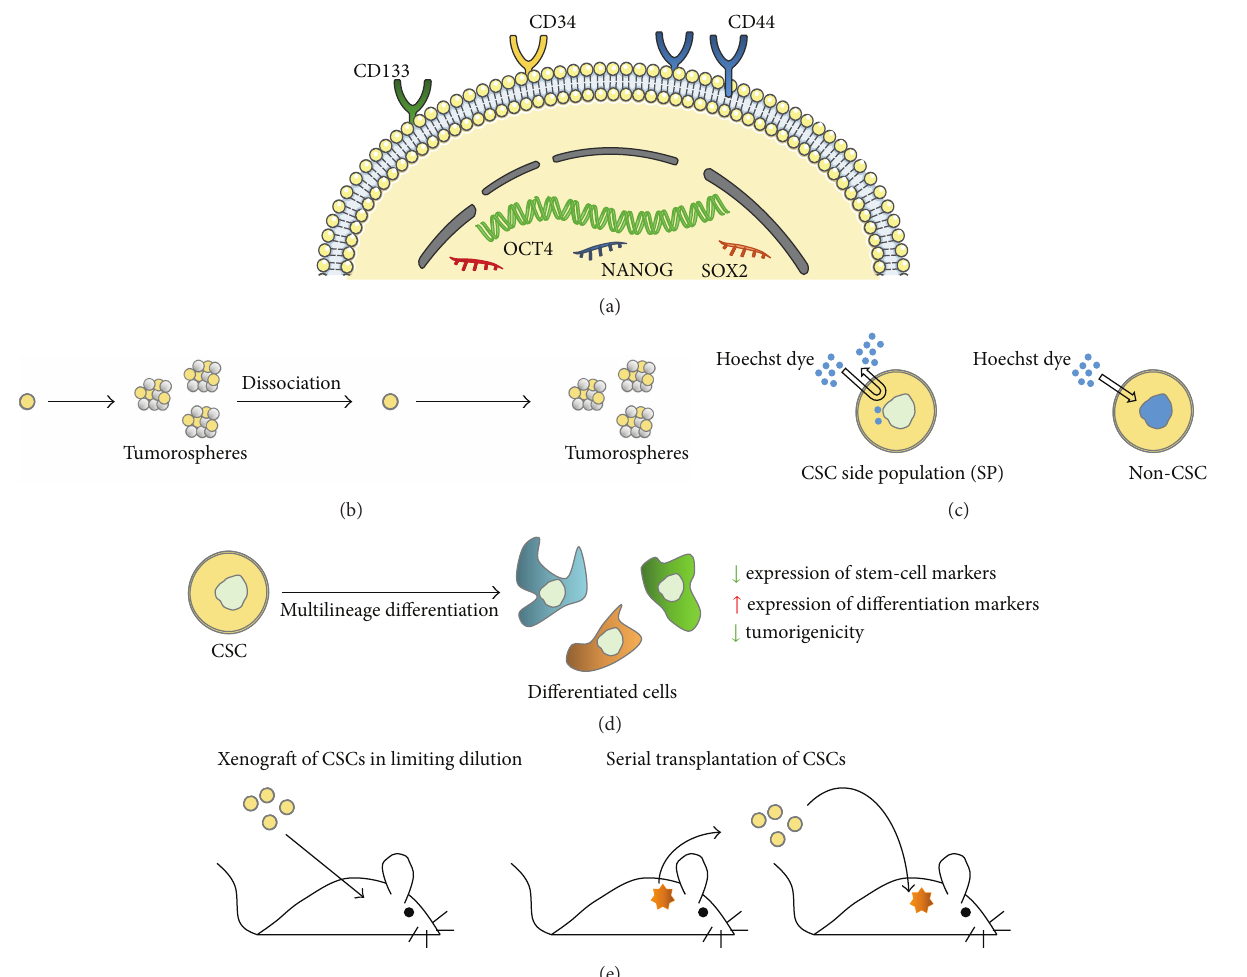
Figure 1: Cancer stem cell (CSC) properties and experimental methods for phenotypic and functional characterization of CSCs. (a) CSCs